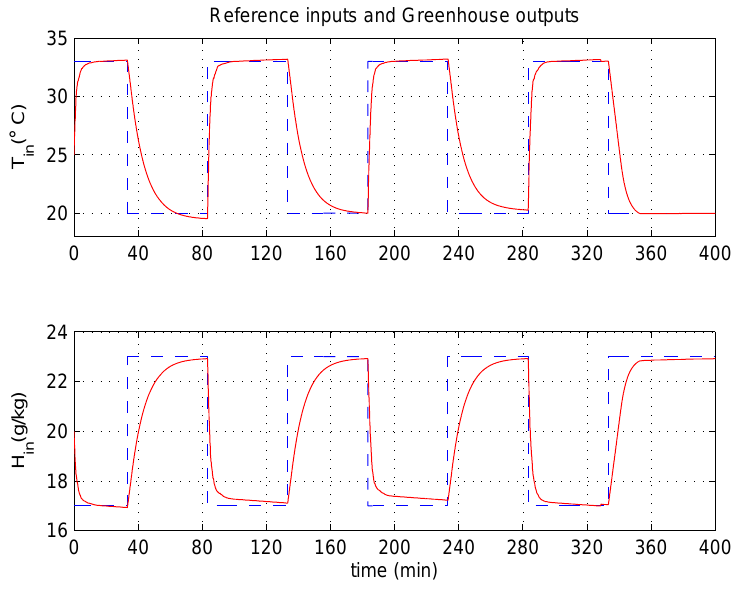
Figure 6. Neuro-PID controller tracking trajectory of square-wave for temperature and humidity